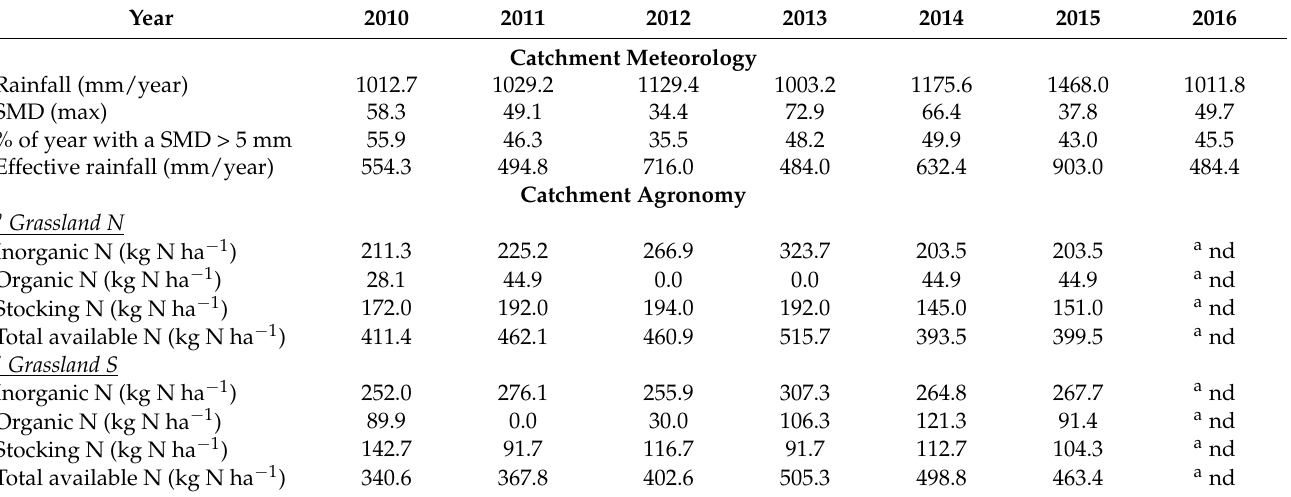
Table 6. Grassland catchment annual totals (2010–2016) of rainfall and effective rainfall, maximum accumulated SMD and the percentage of each year with a SMD in excess of 5 mm. The chemical N, organic N, stocking N and total available N inputs to the land surface from 2010 to 2016 are also